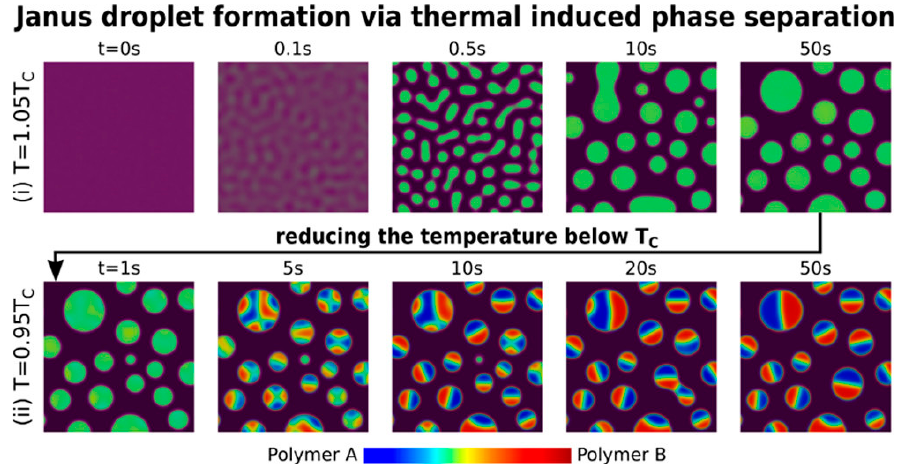
Figure 9. Schemes showing the thermally induced phase separation for the formation of Janus droplets. Reproduced with permission from Zhang et al. (2022), ©American Chemical Society (ACS), 2022 [70].